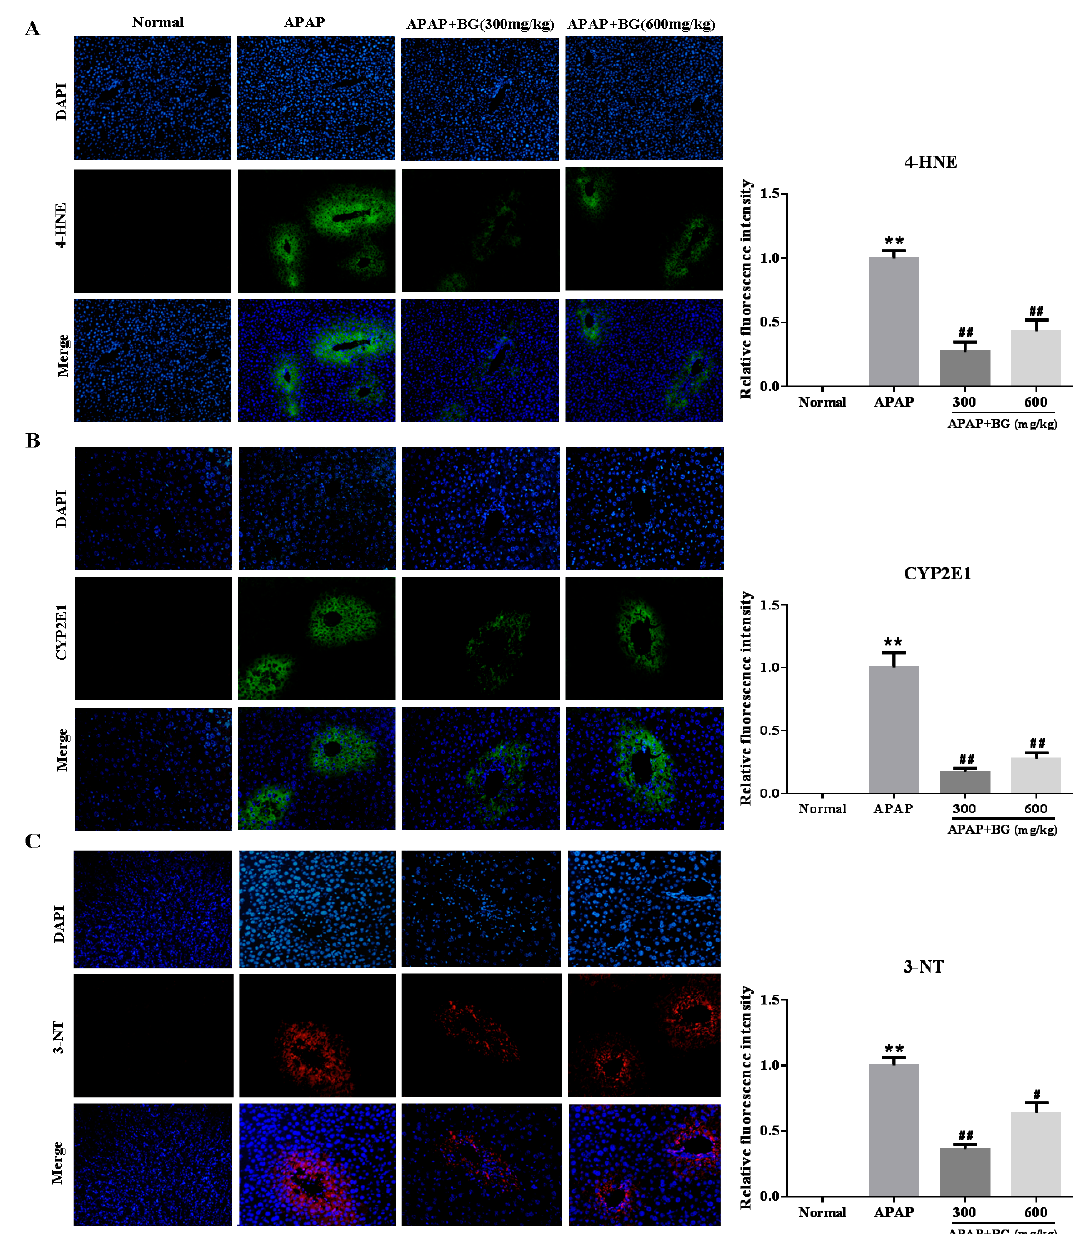
Figure 3. Effects of BG on expression of 4-hydroxynonenal (4-HNE) ( A ), cytochrome P450 E1 (CYP2E1) ( B ) and 3-nitrotyrosine (3-NT) ( C ) in liver tissues, and the fluorescence intensities were quantified. The expression levels of 4-HNE, CYP2E1 (green) and 3-NT (red) in tissue section isolated from different groups were assessed by immunofluorescence. Representative immunofluorescence images were taken at 200 × . 4,6-Diamidino-2-phenylindole (DAPI) (blue) was used as a nuclear counterstain. All data were expressed as mean ± S.D, n = 8. ** p < 0.01 vs. normal group; ## p < 0.01, # p < 0.05, vs. APAP